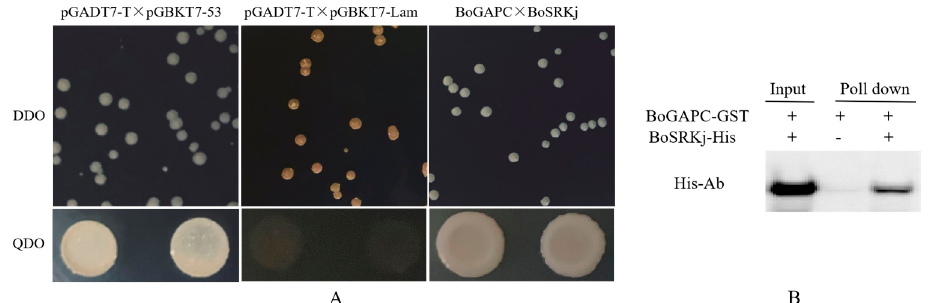
Figure 12. ( A ) Test protein–protein interactions on SD/-Leu/-Trp plate and SD/-Ade/-His/-Leu/-Trp plate. DDO: SD/-Leu/-Trp, QDO: SD/-Ade/-His/-Leu/-Trp. Positive control: pGADT7-T × pGBDT7-53, negative control: pGADT7-T × pGBDT7-Lam, experimental group: pGADT7-BoGAPC × pGBKT7-BoSRKj. ( B ) In vitro GST pull-down assay for the interaction of BoGAPC and BoSRKj. Purified BoSRKj-His tagged protein was pulled down by BoGAPC-GST fusion protein and was detected by Western blot analysis using His antibody.